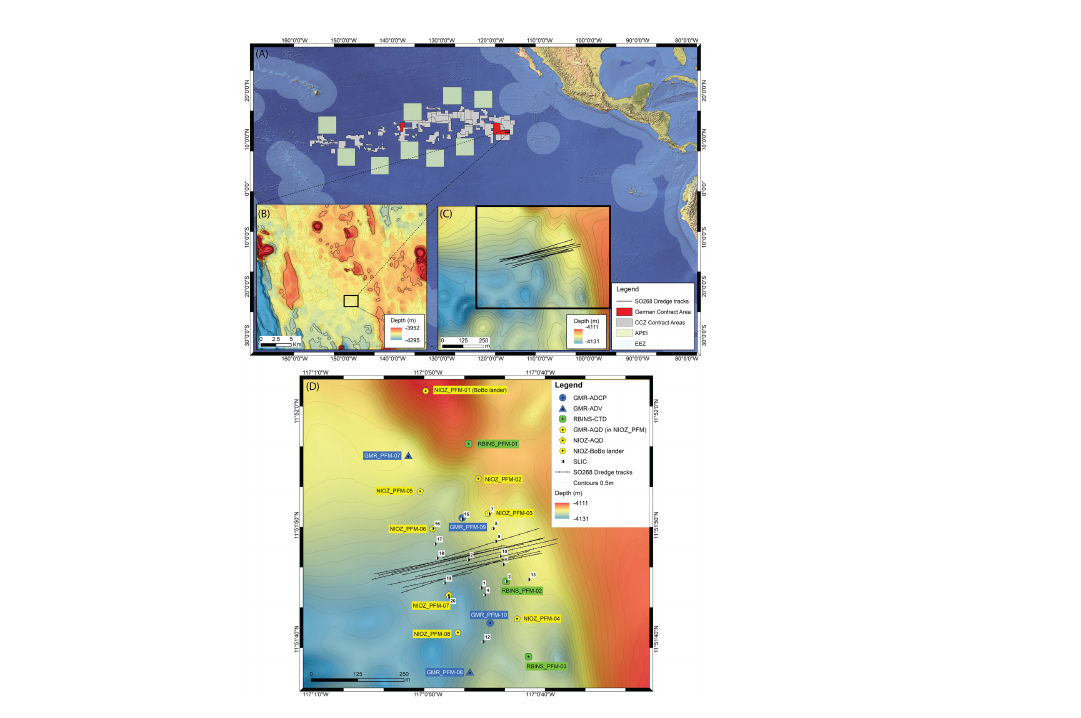
FIGURE 1 | (A) Map showing the overall location of the CCZ with the German exploration contract areas marked in red. The area of the dredge experiment is shown in more detail in the insets (B, C) . The abbreviation APEI stands for Area of Particular Environmental Interest (source: https://isa.org.jm) and EEZ stands for Exclusive Economic Zone (source: https://www.marineregions.org). (D) Locations of the sensor platforms and SLIC boxes in relation to the dredge tracks. The trajectory of the dredge on the bottom was measured during dredging using a USBL beacon mounted to the wire 500 m ahead of the dredge. Post-dredging visual inspection using USBL-navigated OFOS and ROV video footage improved the accuracy of the observed dredge track locations. Sensor platforms of the different scienti fi c institutes involved have been allocated different colours. Bathymetric data were gathered during RV Sonne cruises SO239 (Mart ı ́ nez Arbizu and Haeckel, 2015; Peukert et al., 2018) and SO268 (Gazis, 2020; Haeckel and Linke, 2021). The isobath contour interval in (B) is 100 m for the darker contours and 25 m for the shaded contours, in Figure (C, D) the isobath contour interval is 0.5